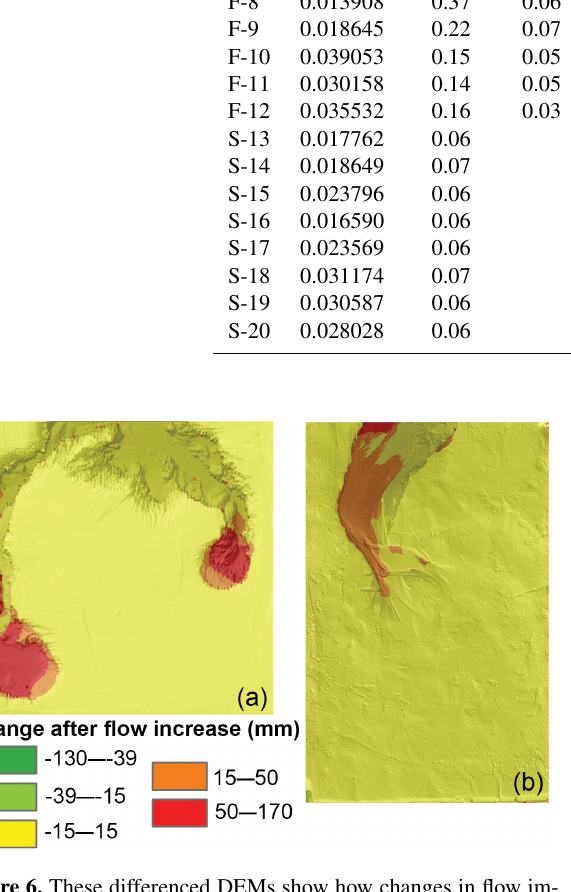
Figure 6. These differenced DEMs show how changes in flow im- pact channel width. In the fine-grained runs (a) the width changed in the newly formed channel, while in the sand runs (b) the channel width was altered along the entire channel length. Flow is bottom to top in both